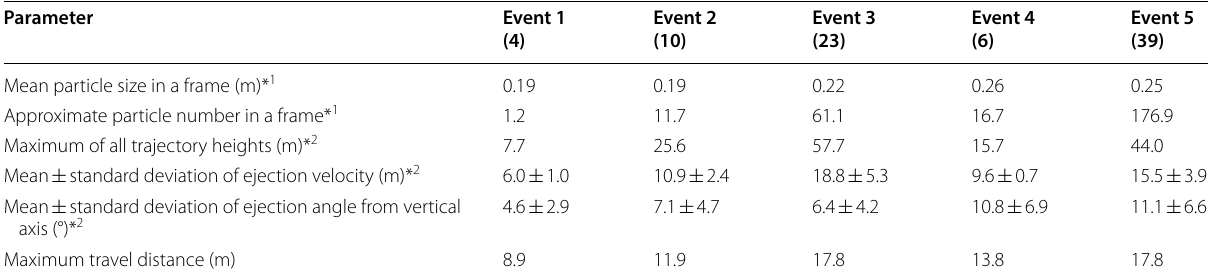
Table 1 Characteristic parameters of each event obtained from binary images (*1) and trajectory analysis (*2)